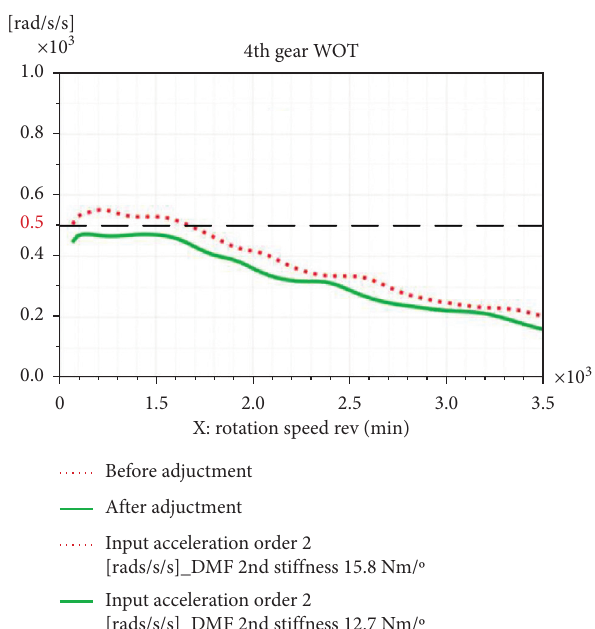
Figure 21: Comparison of simulations before and after